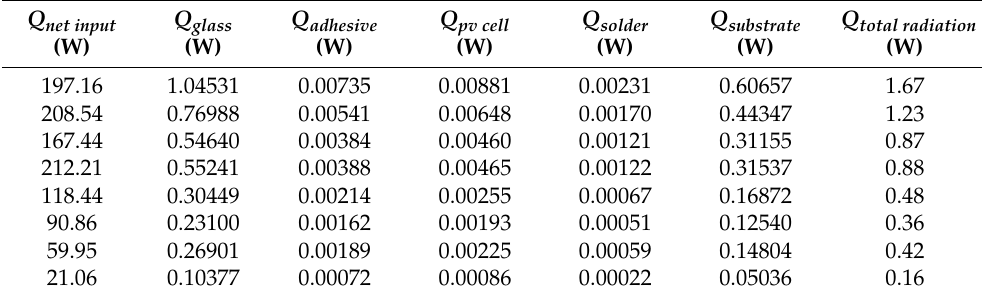
Table 3. Heat transfer through radiation from a different cross section of PV cell.